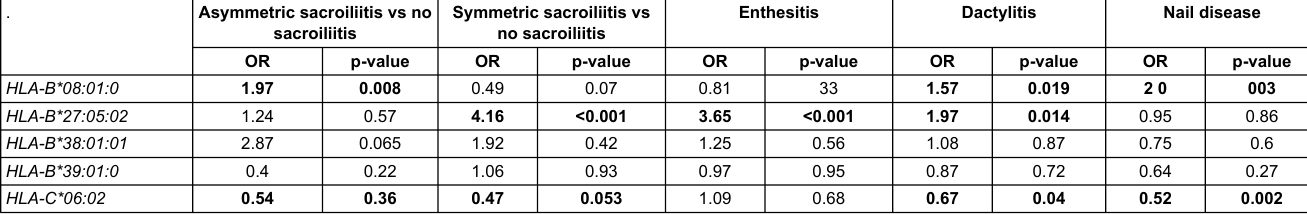
Table 2: Differing genetic architecture underlying development of clinical subtypes of psoriatic arthritis. . Asymmetric sacroiliitis vs no Symmetric sacroiliitis vs Enthesitis Dactylitis Nail sacroiliitis no sacroiliitis